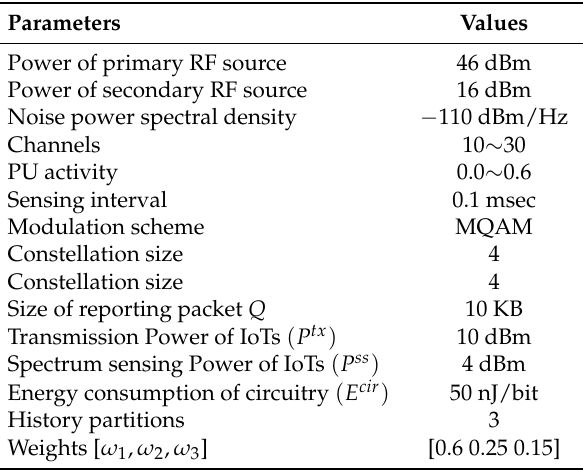
Table 3. Simulation